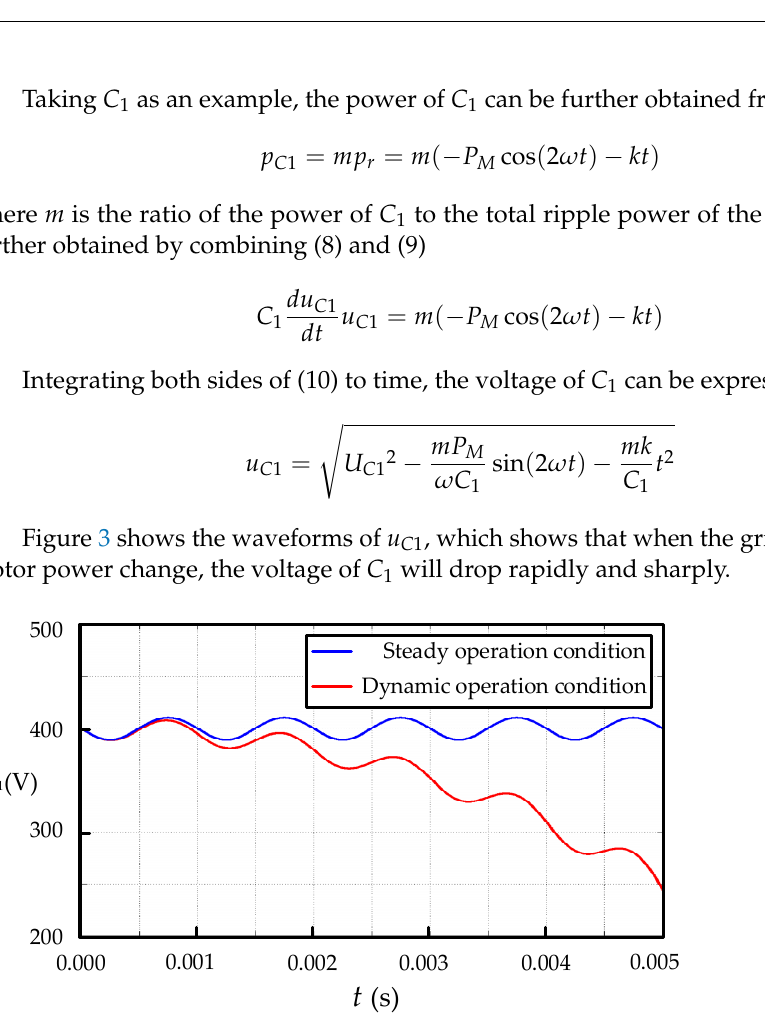
Figure 3. The waveforms of u C 1 under steady operation conditions and dynamic operation condi- tions.